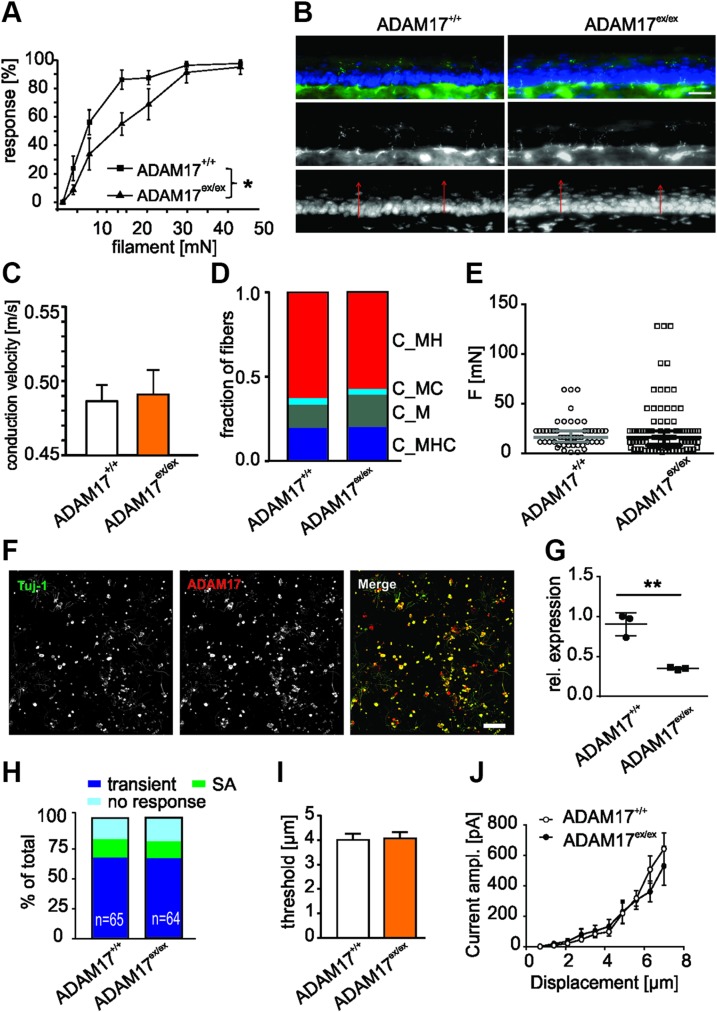
ADAM17ex/ex mice show reduced sensitivity to noxious mechanical stimulation in vivo. A) ADAM17ex/ex mice showed higher mechanical von Frey thresholds compared with ADAM17+/+ animals (n = 8; 1-way repeated measurements ANOVA, P = 0.0156; Tukey’s post hoc test ADAM17+/+
vs. (ADAM17+/ex) P = 0.0477; ADAM17+/+
vs. heterozygous for ADAM17 mice (ADAM17+/ex) P = 0.2360; ADAM17+/ex
vs. ADAM17ex/ex
P = 0.0809). B) Representative image of skin sensory innervation. ADAM17ex/ex mice had similar skin innervation pattern (3.08 ± 0.41 vs. 2.59 ± 0.16 nerve endings per 1000 µm2; n = 4; P = 0.306, Student’s t test) and epidermis thickness (35.10 ± 3.16 vs. 37.12 ± 2.54 µm; n = 4; P = 0.637, Student’s t test). Scale bar, 20 µm. C) Overall conduction velocities of the 2 genotypes were similar (ADAM17+/+: n = 38, median 0.49 m/s; ADAM17ex/ex: n = 54, median 0.46 m/s, P = 0.4353, Mann-Whitney U test). D) C-fibers (C_) are classified by the modalities heat (H), cold (C), and mechanical force (M). The frequency distribution of different C-fiber types shows no statistical significance between the 2 genotypes (ADAM17+/+
n = 51; ADAM17ex/ex
n = 88; P = 0.8465; χ2 = 0.8122, χ2 test). E) Dot-plot depicting the mechanical threshold of mechanically sensitive C-fibers between ADAM17+/+ and ADAM17ex/ex mice (ADAM17+/+: n = 51, median 16.00 mN; ADAM17ex/ex: n = 88, median 13.7 mN, P = 0.3814, Mann-Whitney U test). F) Twenty-four hour DRG cultures showed input resistance–positive neurons for ADAM17. Adult neurons are costained for Neuron-specific class III beta-tubulin and ADAM17. Scale bar, 250 µm. G) ADAM17 mRNA expression was down-regulated in DRG neuronal cultures from ADAM17ex/ex mice (n = 3; Mann‐Whitney U test, P = 0.0027). H) Stacked histograms showing the proportions of different mechanosensitive currents in sensory neurons from ADAM17+/+ and ADAM17ex/ex mice. Ablation of ADAM17 did not change the proportion of transient currents and SA currents in sensory neurons (χ2 test, n = 64–65, P = 0.95). I) Quantitative comparison of displacement threshold of mechano-gated currents in ADAM17+/+ and ADAM17ex/ex sensory neurons. Displacement threshold was determined as mechanical stimulus that elicited a current ≥20 pA. Depletion of ADAM17 did not alter displacement threshold in DRG neurons (P = 0.86, unpaired Student’s t test, n = 43–44). J) Stimulus-response curve of mechanosensitive currents in ADAM17+/+ and ADAM17ex/ex sensory neurons. Genetic depletion of ADAM17 did not affect mechanosensitive currents (P > 0.49, 2-way ANOVA with post hoc Bonferroni’s test, n = 52–54). Results are shown as means ± sem. *P < 0.05, **P < 0.01.